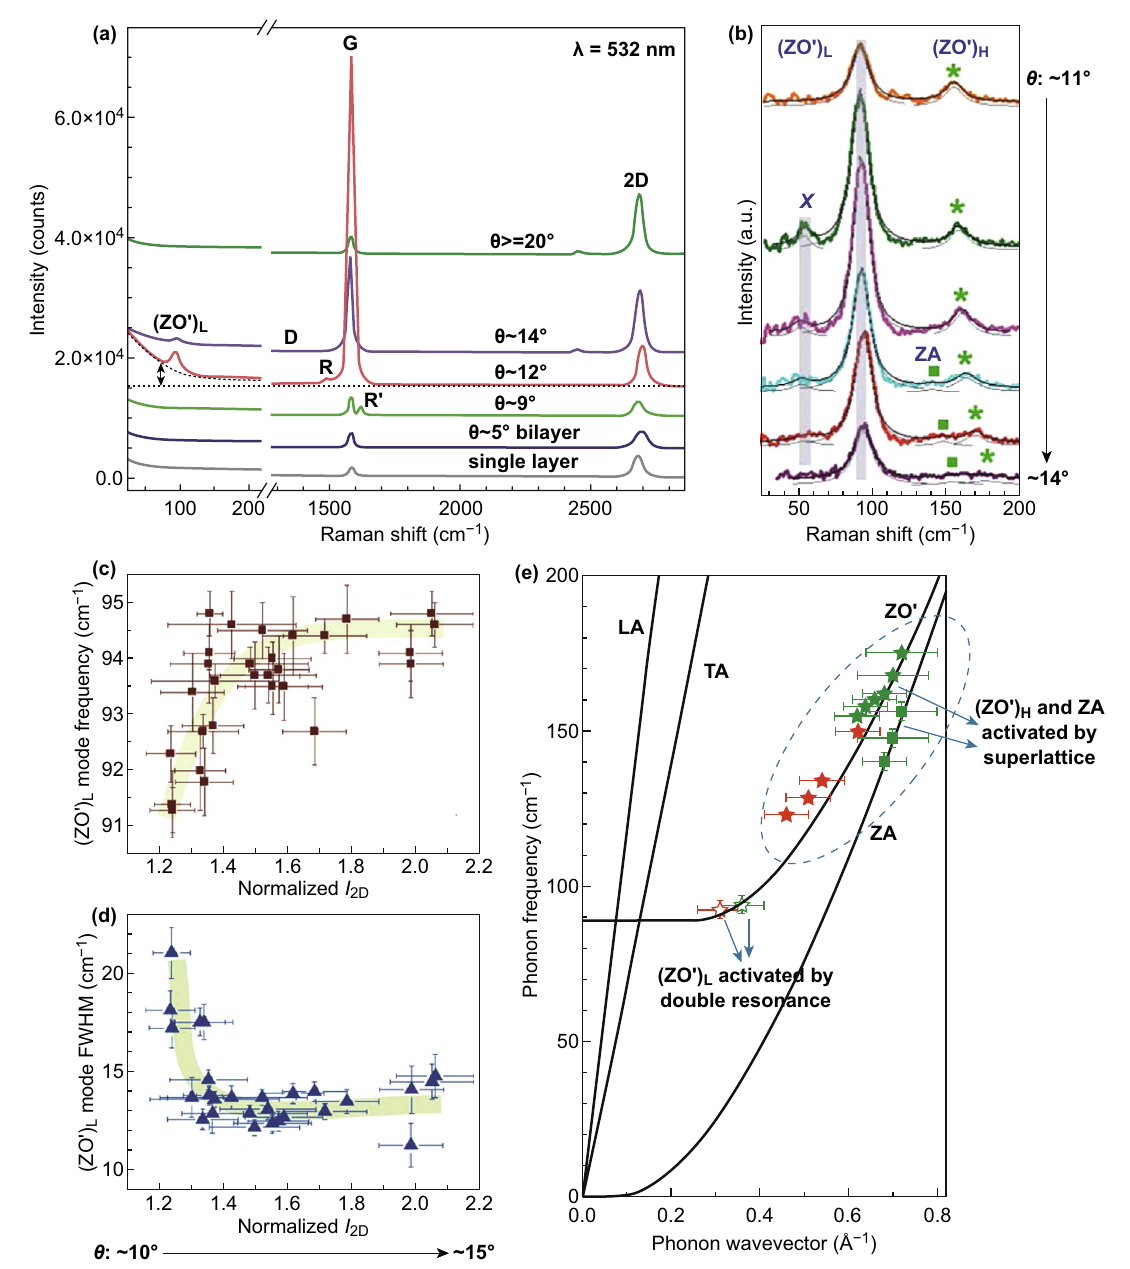
Fig. 3 a Raman spectrum of tBLG with different twisting angles excited by a 532 nm laser excitation. b Background-subtracted low-energy Raman spectrum of six tBLG domains, the gray vertical bars highlight X and (ZO ′ ) L modes, and the squares and the asterisks highlight ZA and (ZO ′ )H modes, respectively. c Frequency and d FWHM of the (ZO ′ ) L mode as a function of normalized I 2D . e Low-frequency phonon dispersion [115]. Adapted with permission from Ref.